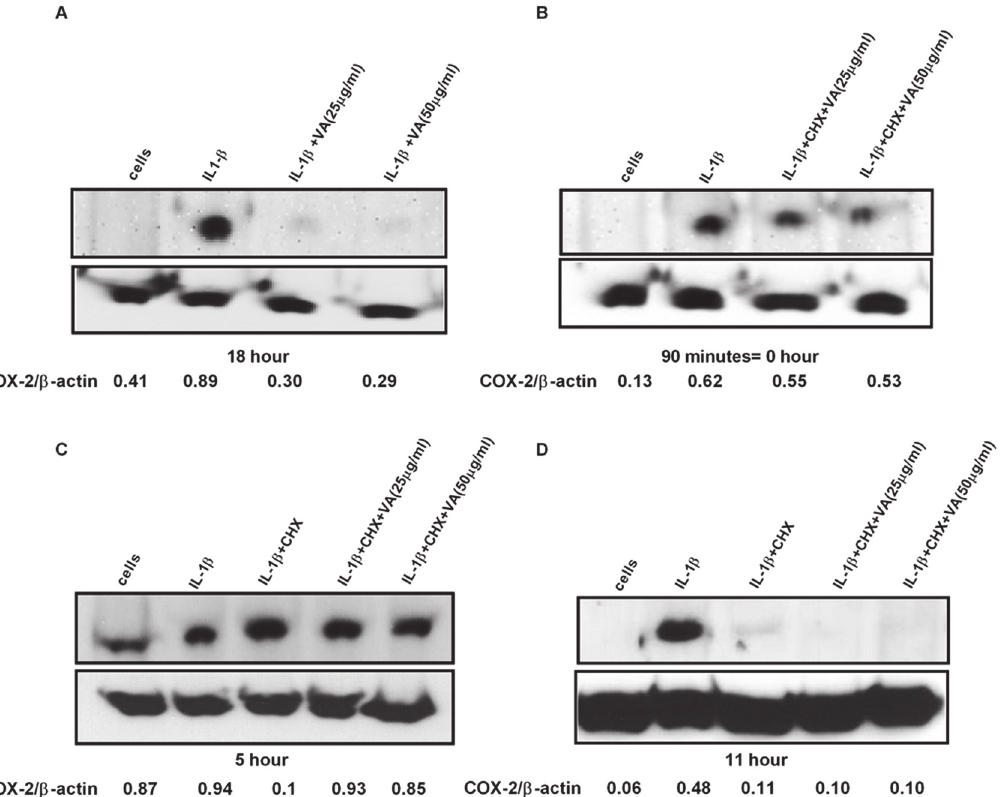
Fig 3. Effect of Viscum album on the stability of COX-2 protein as determined by western blot. Confluent A549 cells were treated with IL-1 β in the presence and absence of VA Qu Spez in dose dependent concentrations in μ g/ml. Cells were harvested at different time intervals after blocking the protein synthesis with cyclohexamide (10 μ g/ml) for 90 minutes till 11 hours. COX-2 expression was measured by western blot using the cytosolic extracts. (A), inhibition of COX2 protein synthesis by VA at 18 hours. (B) (C) (D) are the representative western blots after 90 minutes, 5 hours and 11 hours respectively showing level of COX-2 expression after cyclohexamide treatment with or without Viscum album . β -actin was used as an internal control. All blots are representative of three independent experiments and the densitometry values for each band are mentioned below the representative blots.